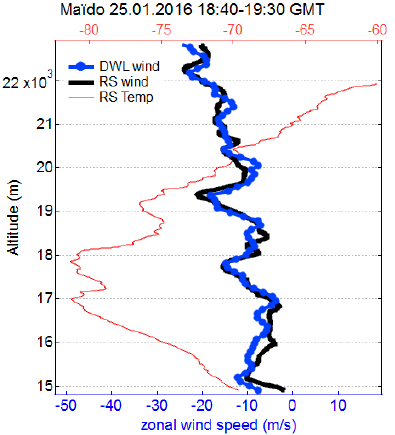
Figure 2. Fine vertical structures in zonal wind profiles (bottom axis) from Maido Doppler wind lidar (blue curve) and collocated radiosounding (black curve). Radiosonde temperature profile (top axis, red curve). The date and time interval of the lidar acquisition/ radiosonde measurement are indicated in the top of the panel.